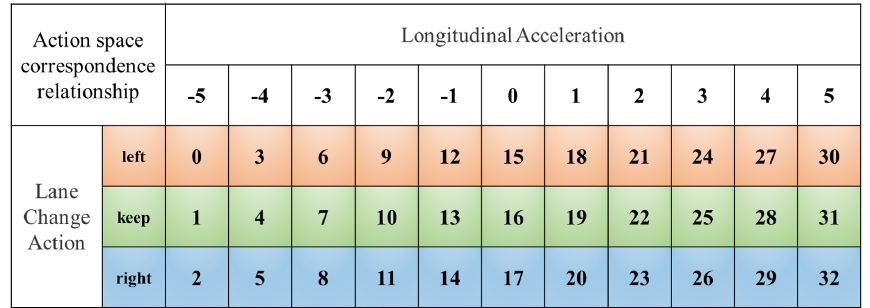
Figure 5. Model action space diagram. The matrix row direction divides the longitudinal acceleration into discrete values, and the matrix column direction represents the lateral lane change of the vehicle.